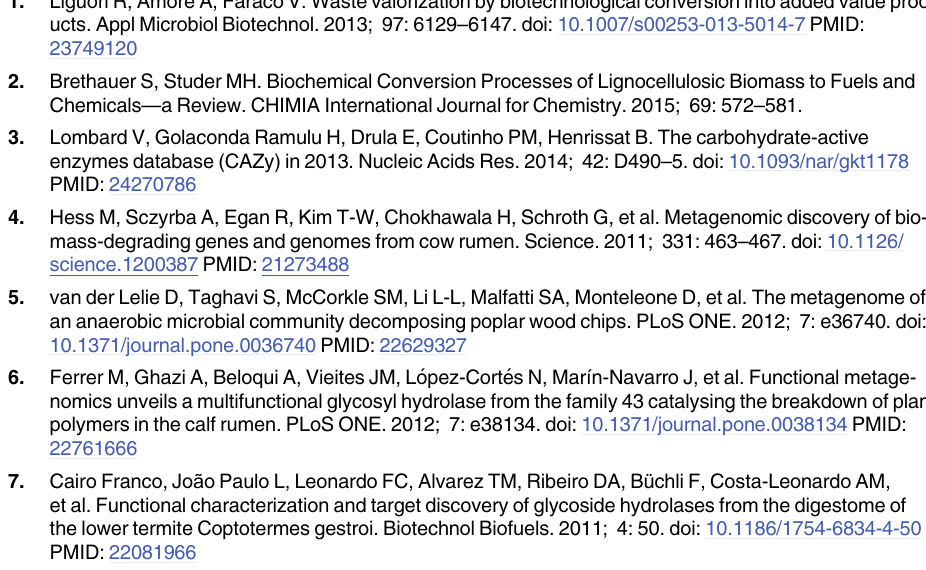
S1 Table. Statistics of assembly using Abyss, CLC or Metavelvet algorithms.